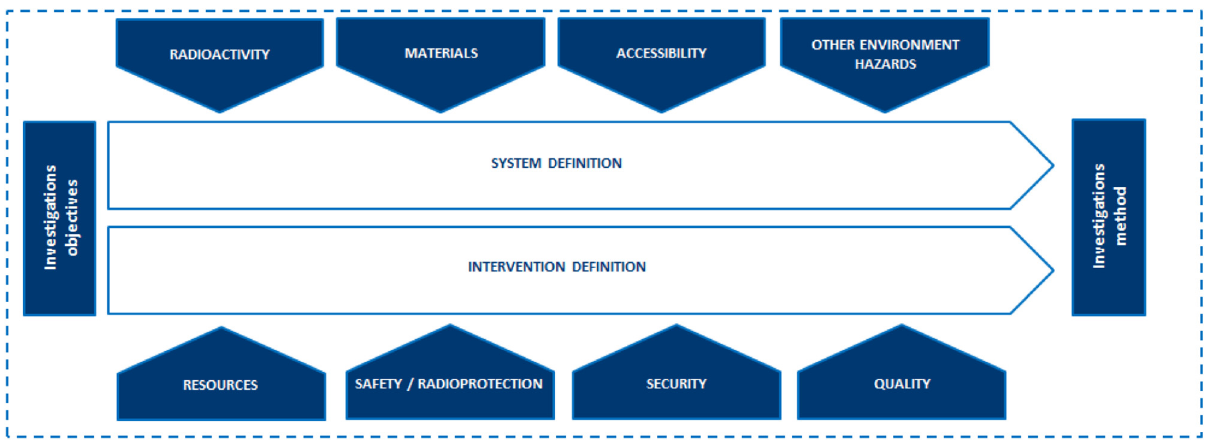
Fig. 3. From Investigation objective to investigation methods.